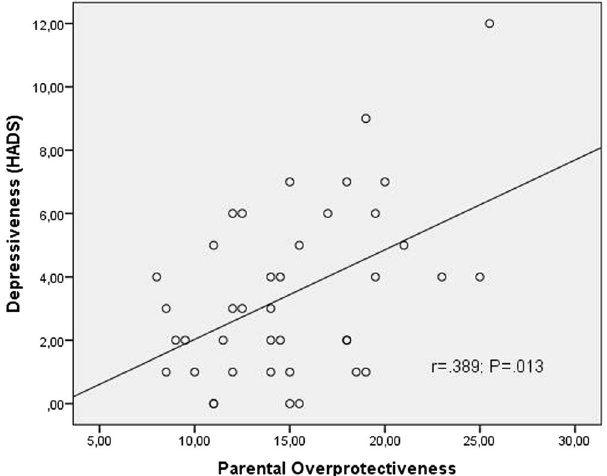
Figure 4. Spearman’s correlations between depressiveness and parental overprotecting. The level of “parental overprotecting” was generated by using the mean-values of maternal and paternal parental overprotecting of the Recalled Parental Rearing Behavior Questionnaire (FEE). Depressiveness was captured by using the hospital anxiety and depression scale